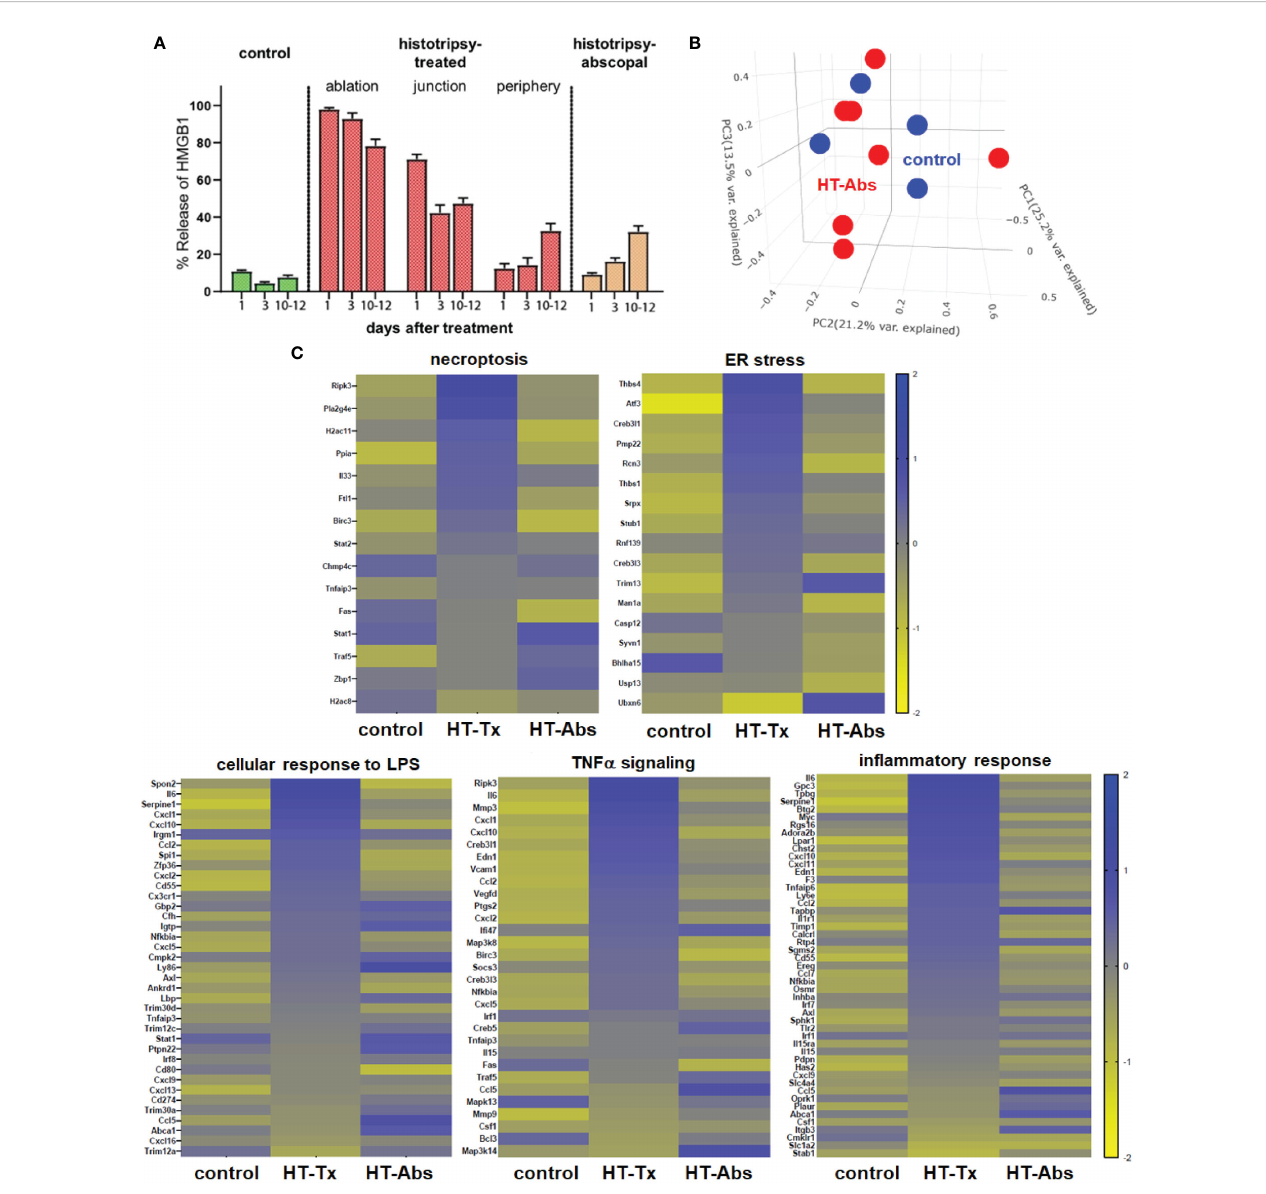
FIGURE 2 Early cellular stress and immunogenic cell death is observed in treated tumors but not distant untreated tumors following histotripsy. Mice bearing bilateral B16F10 tumors were treated with unilateral sham (control) or partial histotripsy ablation on day 10. (A) Multicolor immuno fl uorescence microscopy analysis of control, histotripsy-treated, and histotripsy-abscopal tumors on days 1, 3 or 10-12 after unilateral sham or partial histotripsy ablation revealed no signi fi cant release of intranuclear HMGB1 in control tumors at any time point. Histotripsy-treated tumors exhibited signi fi cant and immediate loss of nuclear HMGB1 staining that was highest within the ablation zone and the junction of ablated and peripheral non-ablated zones at early time points. At later time points, progressive loss of nuclear HMGB1 was observed within peripheral non-ablated zones of histotripsy-treated tumors. Similarly, whereas contralateral histotripsy-abscopal tumors demonstrated no HMGB1 translocation at early time points, progressive loss of intranuclear HMGB1 staining was observed at later time points. (B) RNASeq of CD45- tumor cells from sham-treated control tumors (blue) and histotripsy-abscopal ( “ HT-Abs ” ) tumors (red) performed 3 days after unilateral partial histotripsy revealed no substantial differences in overall mRNA transcriptional activity as evidenced by principal component analysis. (C) RNASeq of CD45- tumor cells 3 days after sham or unilateral histotripsy ablation demonstrated upregulated transcription of genes associated with necroptosis, ER stress, cellular response to LPS, TNF a signaling and in fl ammatory response in histotripsy-treated tumors ( “ HT-Tx ” ) as compared to control and histotripsy-abscopal ( “ HT-Abs ” ) tumors. (n=3-5 mice per experimental